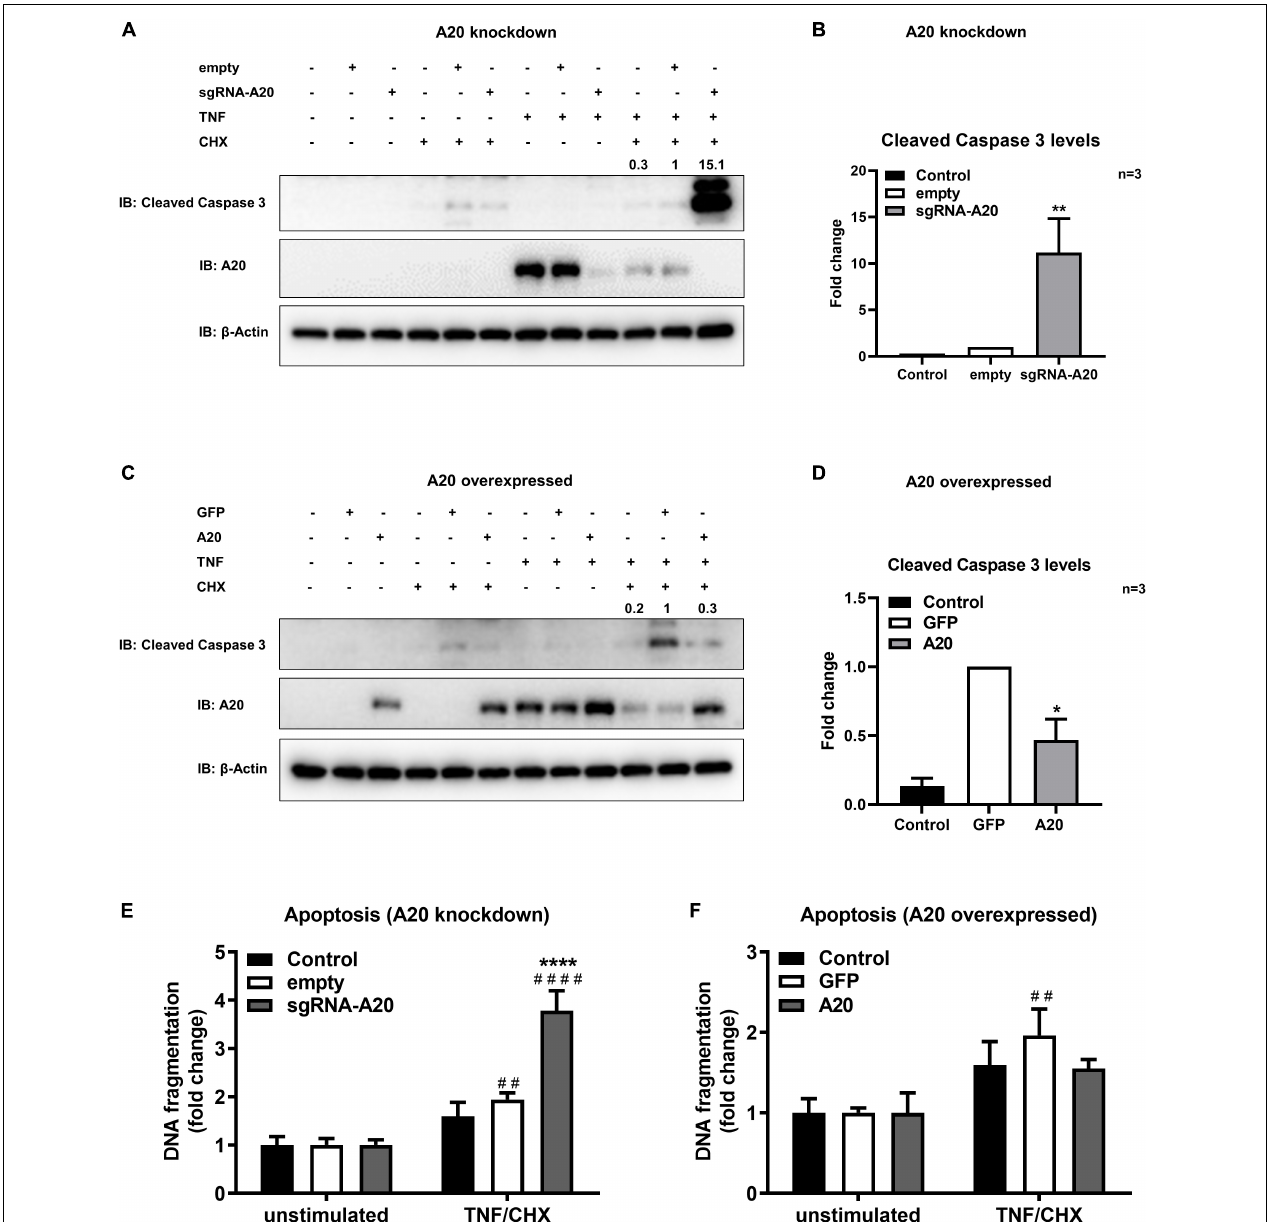
FIGURE 8 | A20 restricts apoptosis in gingival keratinocytes induced by TNF/CHX treatment. Western blots detecting cleaved caspase 3 levels in TIGKs with altered A20 expression or control cells with TNF/CHX treatment. Representative blots of cleaved caspase 3 levels in TIGKs with control or A20 knock-down (A) and A20 over-expression (C) with TNF/CHX treatment (TNF 50 ng/mL 24 h, CHX 3 ug/mL 4 h). Relative density of cleaved caspase 3 levels from independent experiments were plotted with mean and standard errors (B,D) . **TNF/CHX treated A20 depleted cells compared to infected controls ( P ≤ 0.01). *TNF/CHX treated A20 overexpressed cells compared to infected controls ( P ≤ 0.05). ELISA detecting cytoplasmic histone associated DNA fragments in TIGKs. A20 depleted and control cells (E) , or A20 over-expressing cells and control cells (F) were treated with TNF/CHX (TNF 50 ng/mL for 24 h, CHX 3 ug/mL for 4 h) and applied to Cell Death Detection ELISA. Each experiment was performed three times independently and the representative experiments were shown. # Unstimulated cells versus corresponding TNF/CHX treated cells ( ## P ≤ 0.01, #### P ≤ 0.0001); ****TNF/CHX treated A20 depleted cells compared to TNF/CHX treated controls ( P ≤